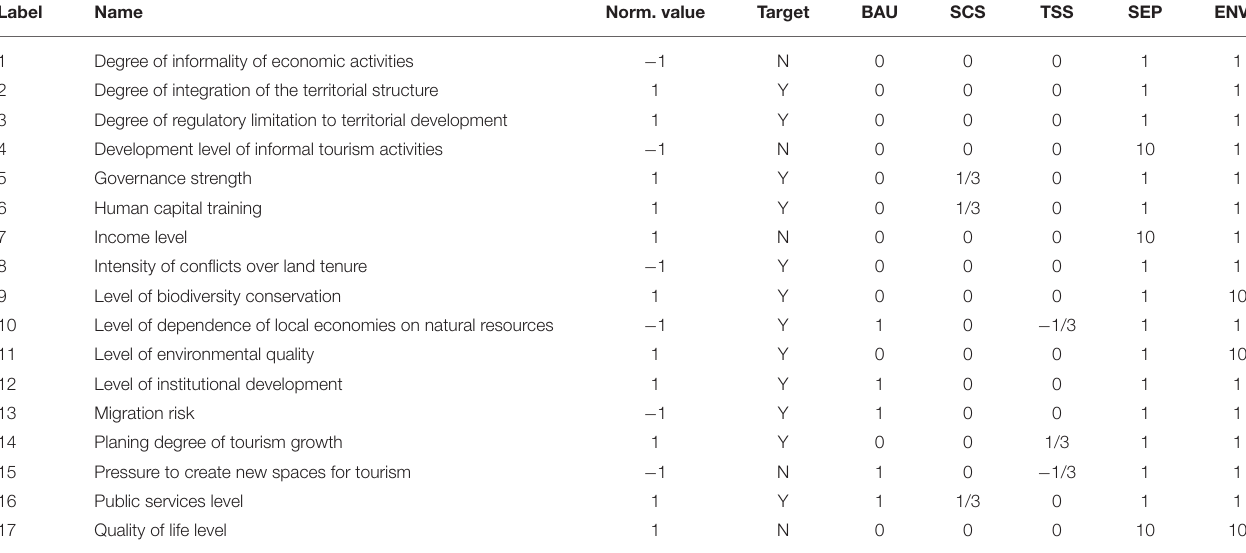
TABLE 1 | Description of system variables, aprioristic scenarios (BAU, business–as–usual; SCS, social containment; TSS, tourism sustainability), and strategic priorities (SEP, social-economic; ENVP, environmental).